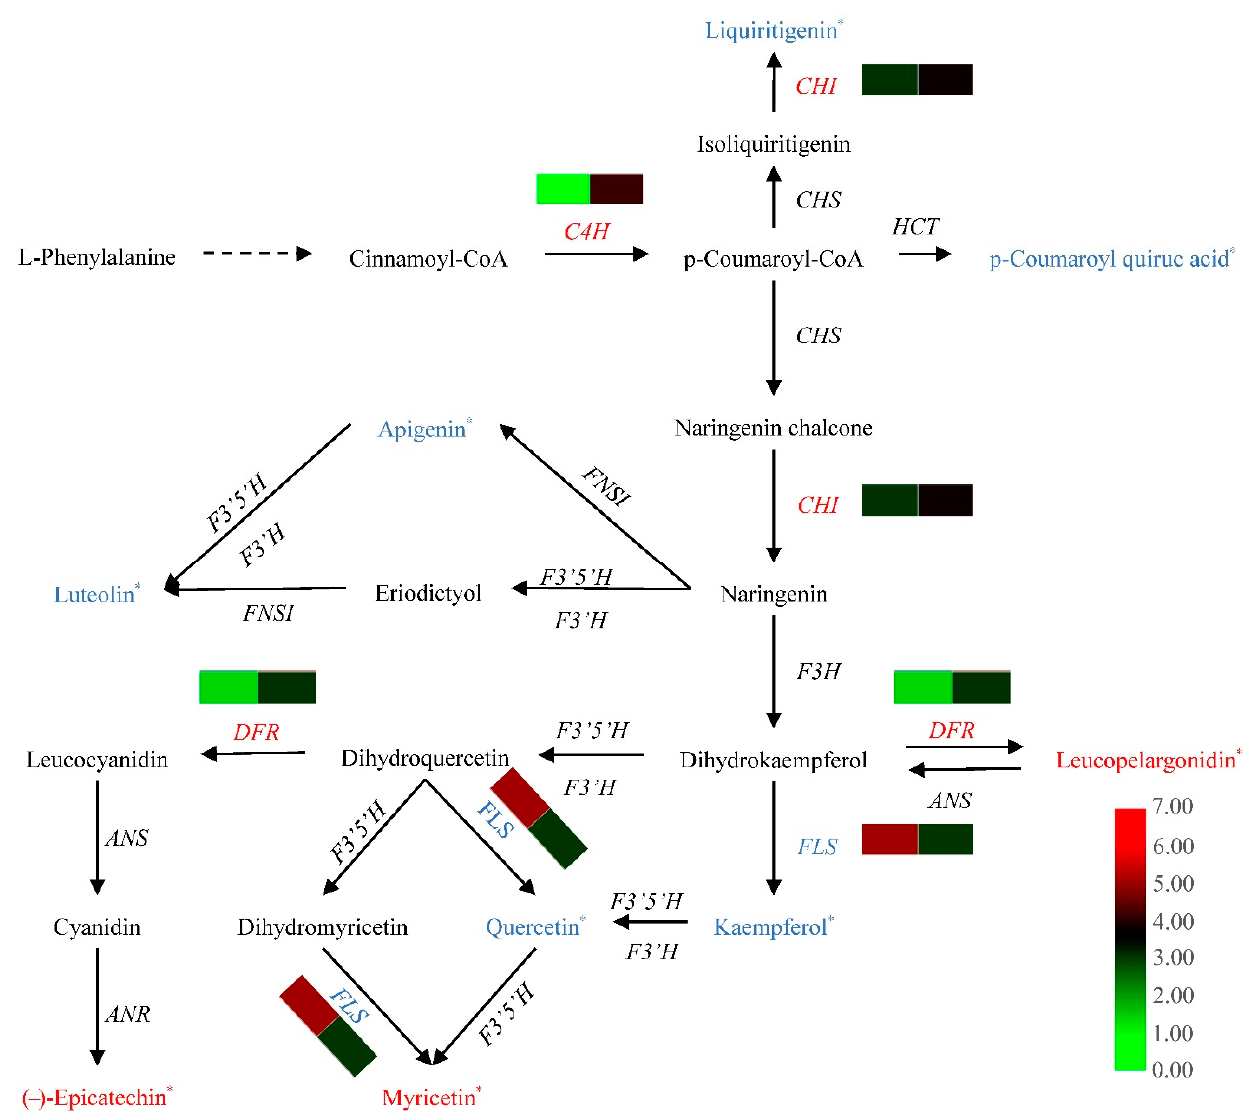
Figure 4. Correlation analysis of flavonoid biosynthesis-related DEGs and DAMs. Different colors in the heatmap indicate different gene expression levels; * indicates that there is a significant difference in the content of the metabolite between the two cultivars. Red indicates that the gene expression level or metabolite content in ‘Huiyuan’ is greater than that in ‘Changying’, and blue indicates that the gene expression level or metabolite content in ‘Huiyuan’ is less than that in ‘Changying’. C4H: cinnamic acid 4-hydroxylase; CHS: chalcone synthase; CHI: chalcone isomerase; HCT: hydroxycinnamoyl-CoA: shikimate hydroxycinnamoyl transferase; FNSI: type I flavone synthase; F3 ′ 5 ′ H: flavonoid-3 ′ -5 ′ -hydroxylase; F3 ′ H: flavonoid-3 ′ -hydroxylase; F3H: flavonone-3-hydroxylase; FLS: flavonol synthase; DFR: dihydroflavonol reductase; ANS: anthocyanidin synthase; ANR: anthocyanidin